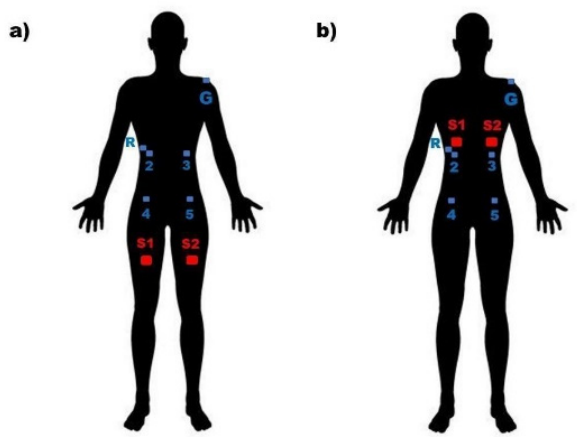
Figure 1. Electrode position. ( a ) Experimental condition non-STI group. ( b ) Experimental condition VSTI group. R: reference electrode; 2: right external oblique electrode; 3: left external oblique electrode; 4: right internal oblique electrode; 5: left internal oblique electrode; G: ground electrode; S1: Stimuli 1 location; S2: Stimuli 2 location.